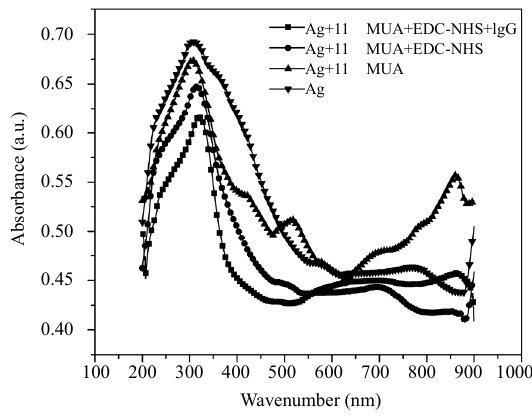
Fig. 3 UV-Vis spectra of the sensor surface before and after antibody immobilization.